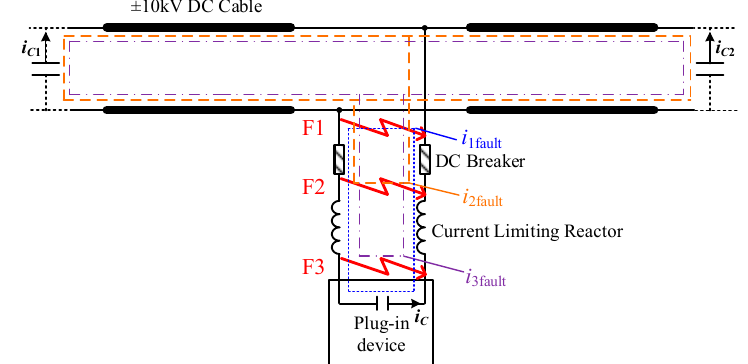
Figure 2. The possible pole-to-pole faults at the line side of plug-in devices.